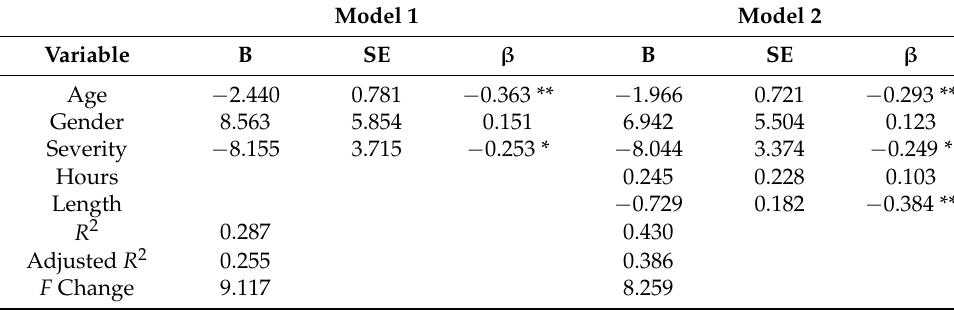
Table 6. Hierarchical Regression Analysis for Prediction of Adaptive Functioning.